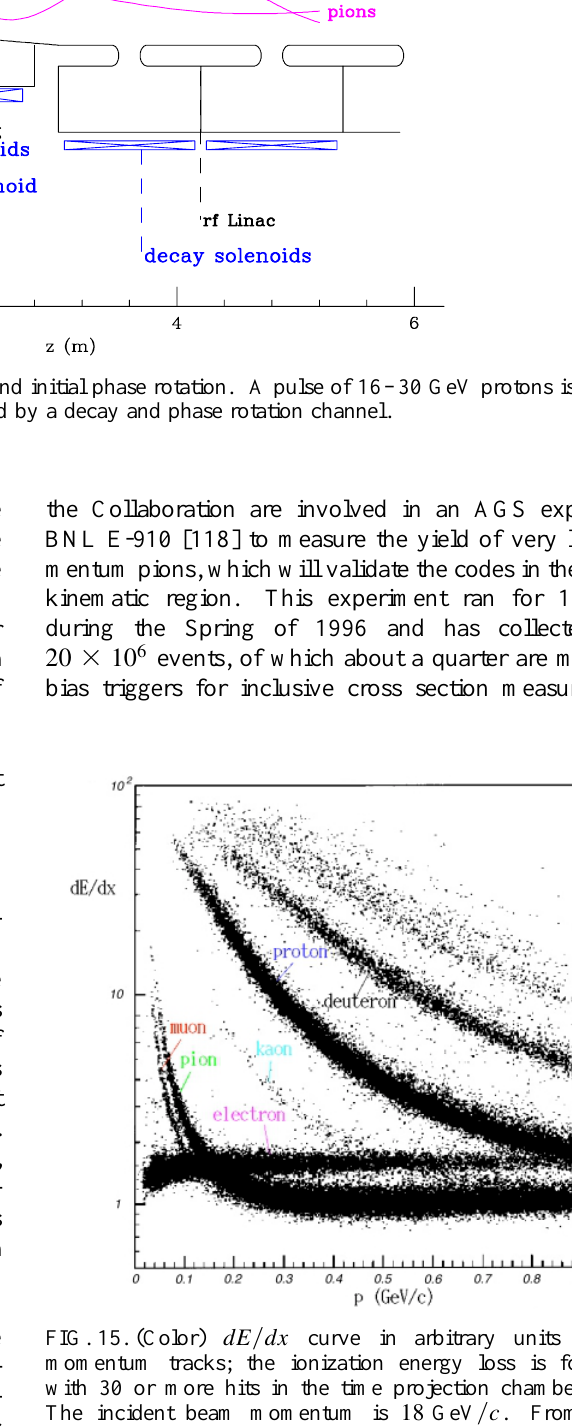
FIG. 15. (Color) dE (cid:1) dx curve in arbitrary units for low momentum tracks; the ionization energy loss is for tracks with 30 or more hits in the time projection chamber (TPC). The incident beam momentum is 18 GeV (cid:1) c . From left to right the bands correspond to muons, pions, kaons, protons, and deuterium, respectively. Note the overlap of the (nearly horizontal) electron band with other